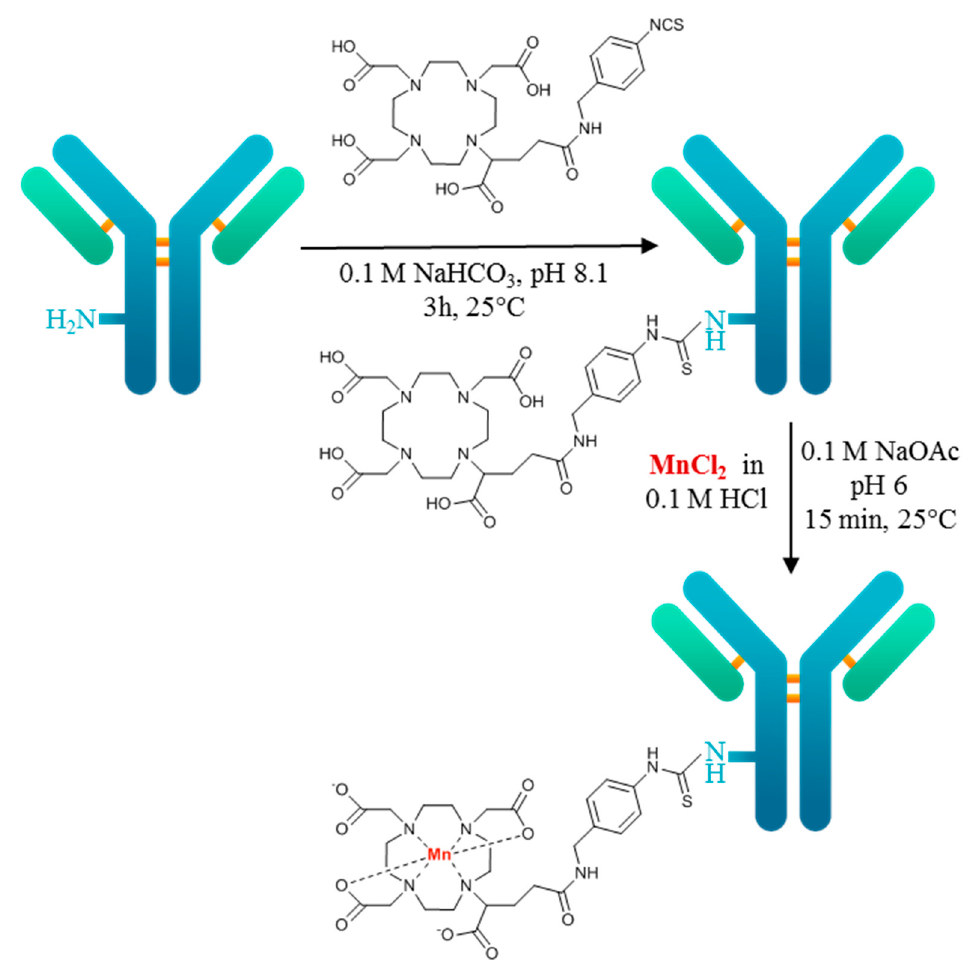
Figure 1. Scheme of the radiochemical synthesis of [ 52 Mn]Mn-DOTAGA-bevacizumab.